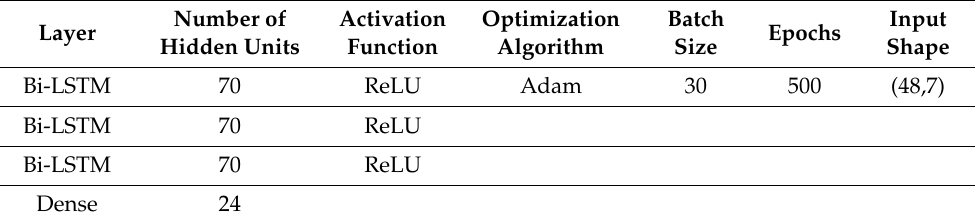
Table 6. Model Architecture for Bi-LSTM.